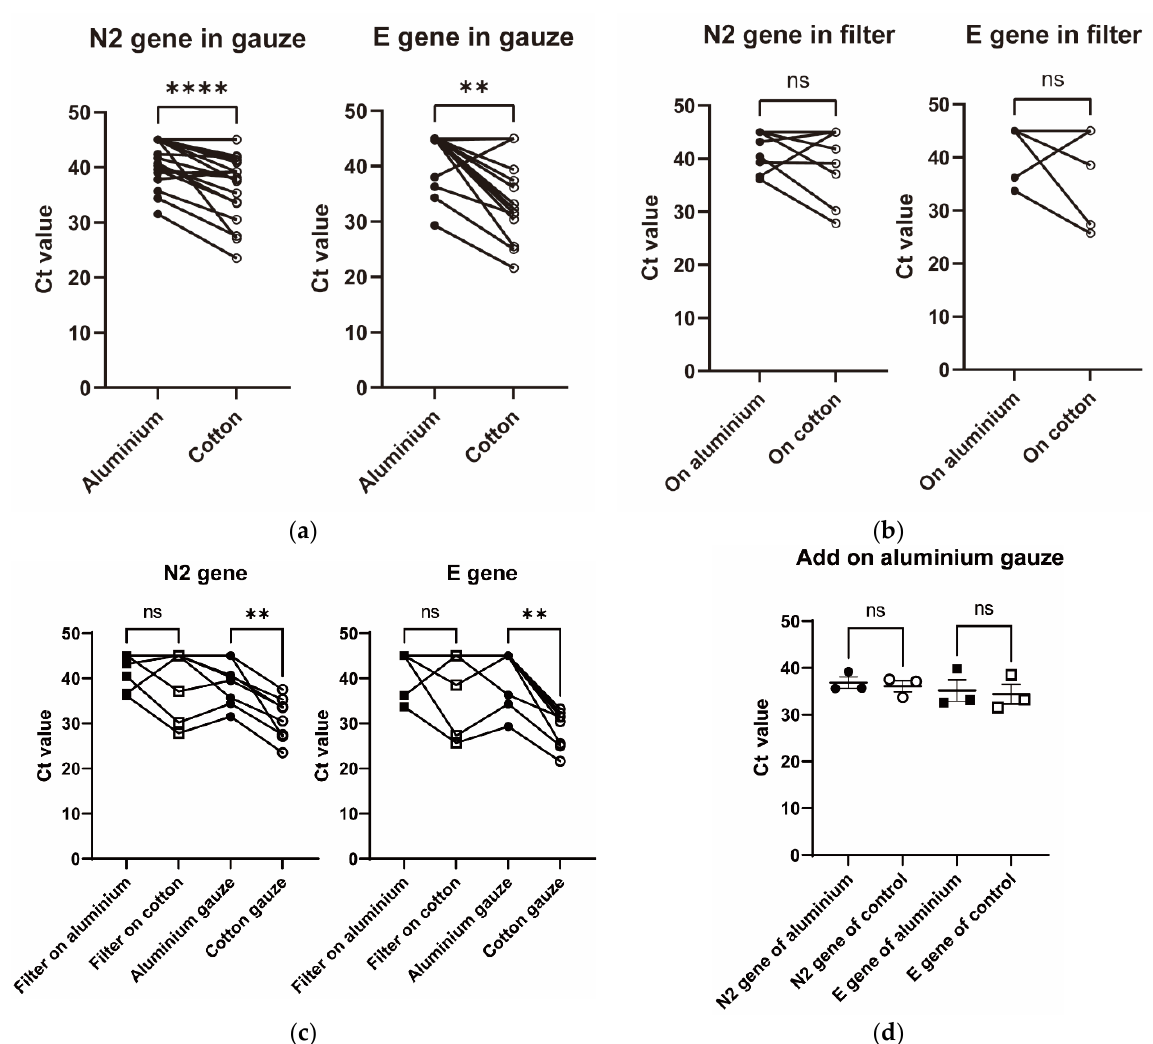
Figure 3. Ct values of N2 or E genes of SARS-CoV-2 in gauzes and filters. Ct values of N2 or E gene of SARS-CoV-2 were compared between cotton gauzes and aluminium gauzes ( a ) or between filters placed behind the cotton and aluminium gauzes ( b ). In the subgroup with a Ct value of less than 35 for either gauze or filter, Ct values of N2 or E gene of SARS-CoV-2 were compared between cotton gauzes and aluminium gauzes or between filters placed behind the cotton and aluminium gauzes ( c ). Ct values of the N2 or E gene of SARS-CoV-2 were evaluated in the filter placed behind the aluminium gauze or in the filter placed behind the cotton gauze ( d ). All p -values were calculated using the Wilcoxon rank sum test. **** indicates p -value < 0.0001. ** indicates p -value < 0.01. Ns indicates statistically non-significant p -value.